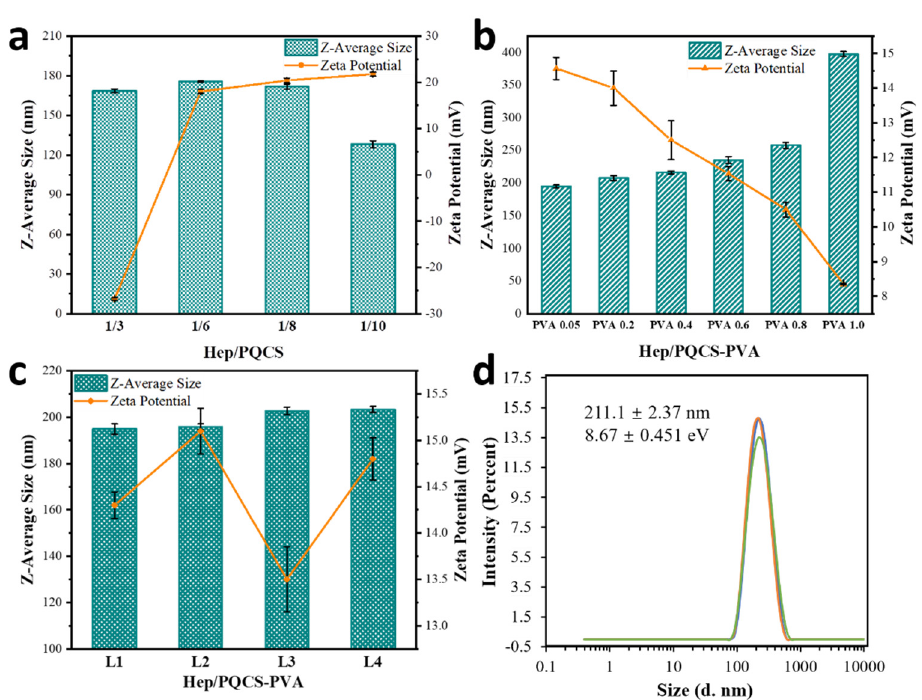
Figure 3. Characterization of DOX-loaded Hep/PQCS-PVA NPs. ( a ) Z-average sizes and zeta potentials of Hep/PQCS aqueous solutions, ( b ) DOX-loaded Hep/PQCS-PVA aqueous solutions, and ( c ) DOX-loaded Hep/PQCS-PVA multilayer NPs in aqueous solutions measured by DLS; ( d ) The particle size of DOX-loaded Hep/PQCS-PVA NPs aqueous solutions measured by dynamic light scattering (DLS) for three times. The concentration of each solution: 0.1 mg mL − 1 .